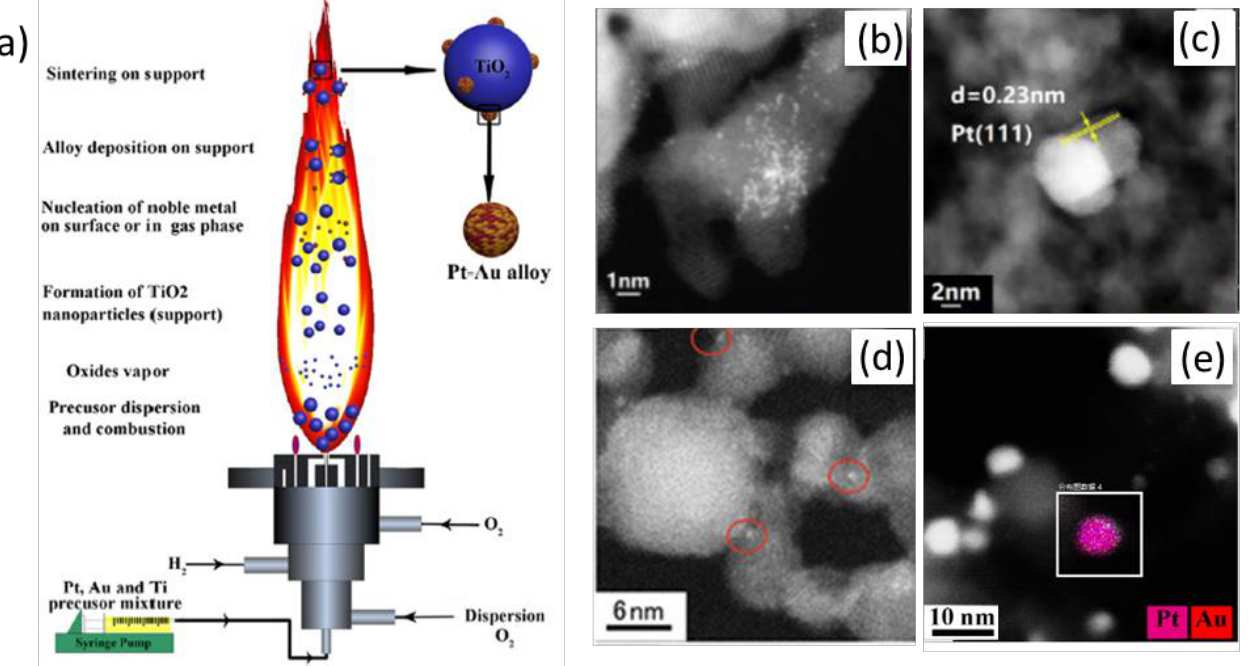
Figure 7. ( a ) Schematics of Pt-Au/TiO 2 formation in FS (Re-printed/adapted with permission from Ref. [105]. Copyright 2020, Elsevier); ( b , c ) S/TEM images of Pt-loaded TiO 2 at low and high concentrations (Re-printed/adapted with permission from Ref. [99]. Copyright 2021, Elsevier); ( d ) S/TEM image of Pd-loaded TiO 2 , red cycles indicate Pd particles (white spots) (Re-printed/adapted with permission from Ref. [101]. Copyright 2016, American Chemical Society); ( e ) S/TEM image of Pt-Au/TiO 2 and EDS elemental mapping of Pt and Au (inside the white square) (Re-printed/adapted with permission from Ref. [105]. Copyright 2020, Elsevier).